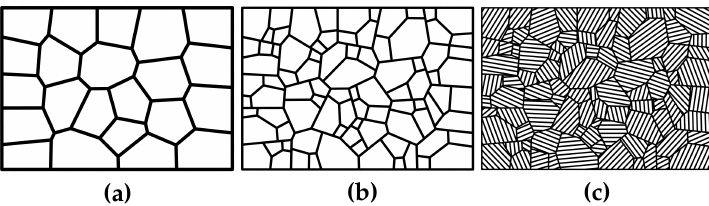
Figure 6. Two-dimensional schematic procedure of the hierarchical modelling approach for lath martensitic microstructures of low carbon-alloyed steels. ( a ) Generation of prior austenite grains. ( b ) Partition of each prior austenite grain into packets. ( c ) Generation of blocks parallel to the corresponding habit plane within individual packets.